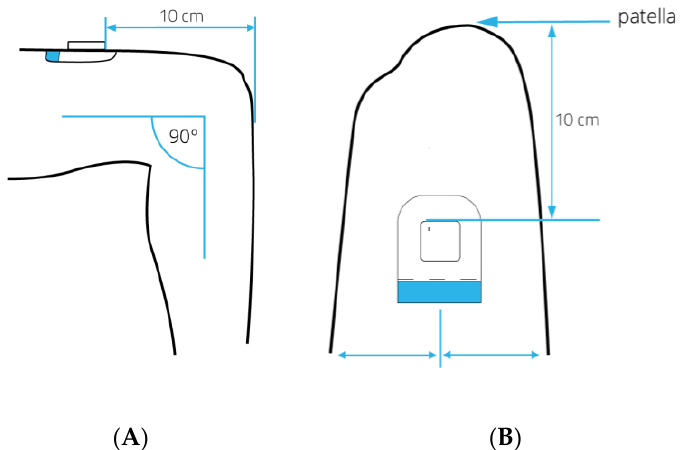
Figure 5. Lateral view ( A ) and frontal view ( B ) of the placement of the MOX activity monitor with the patient in a seated position. Arrows indicate the location of the hypoallergenic patch and sensor on the upper leg, which is 10 cm proximal to the patella.